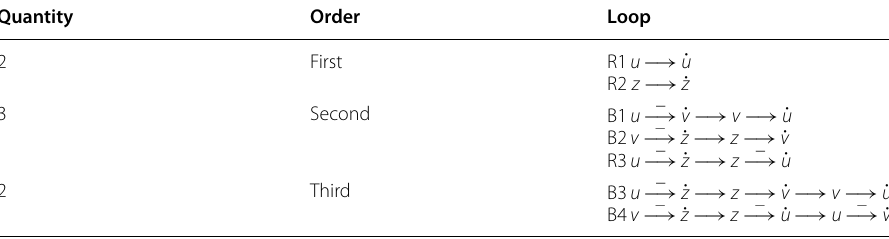
R2 and R3 have been named greed feedback loops in L-1 and L-2